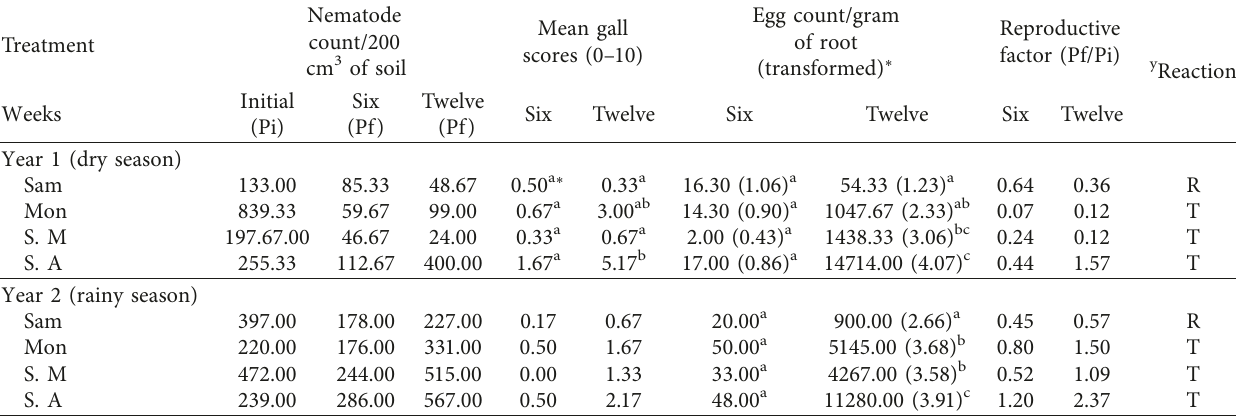
Table 1: Initial and final nematode count, mean gall scores, egg count/g of root, and reproductive factors (RFs) of RKNs after 6 and 12 weeks of transplanting rootstocks in 2015 (year 1) and 2016 (year 2) for field experiments. Treatment